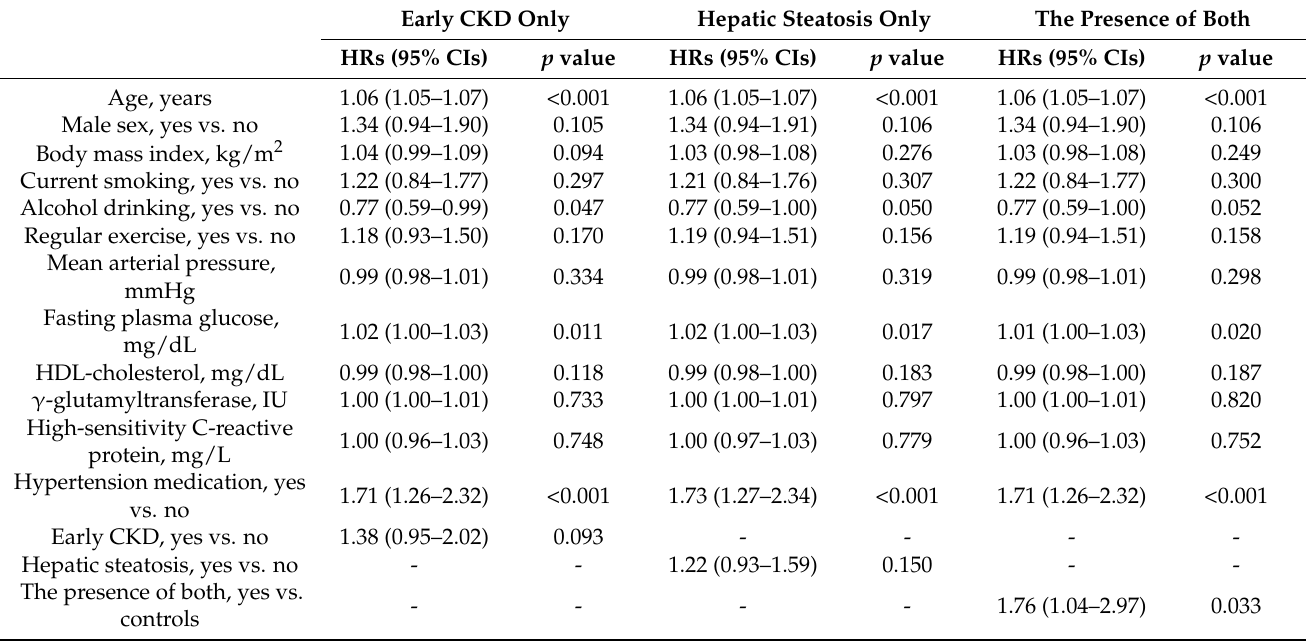
Figure 2. Cumulative incidence of ischemic heart disease during the follow-up time using Kaplan - Meier curve. Table 3. Multivariate Cox proportional-hazards regression models for incident ischemic heart disease by early CKD only, hepatic steatosis only, or the presence of both.